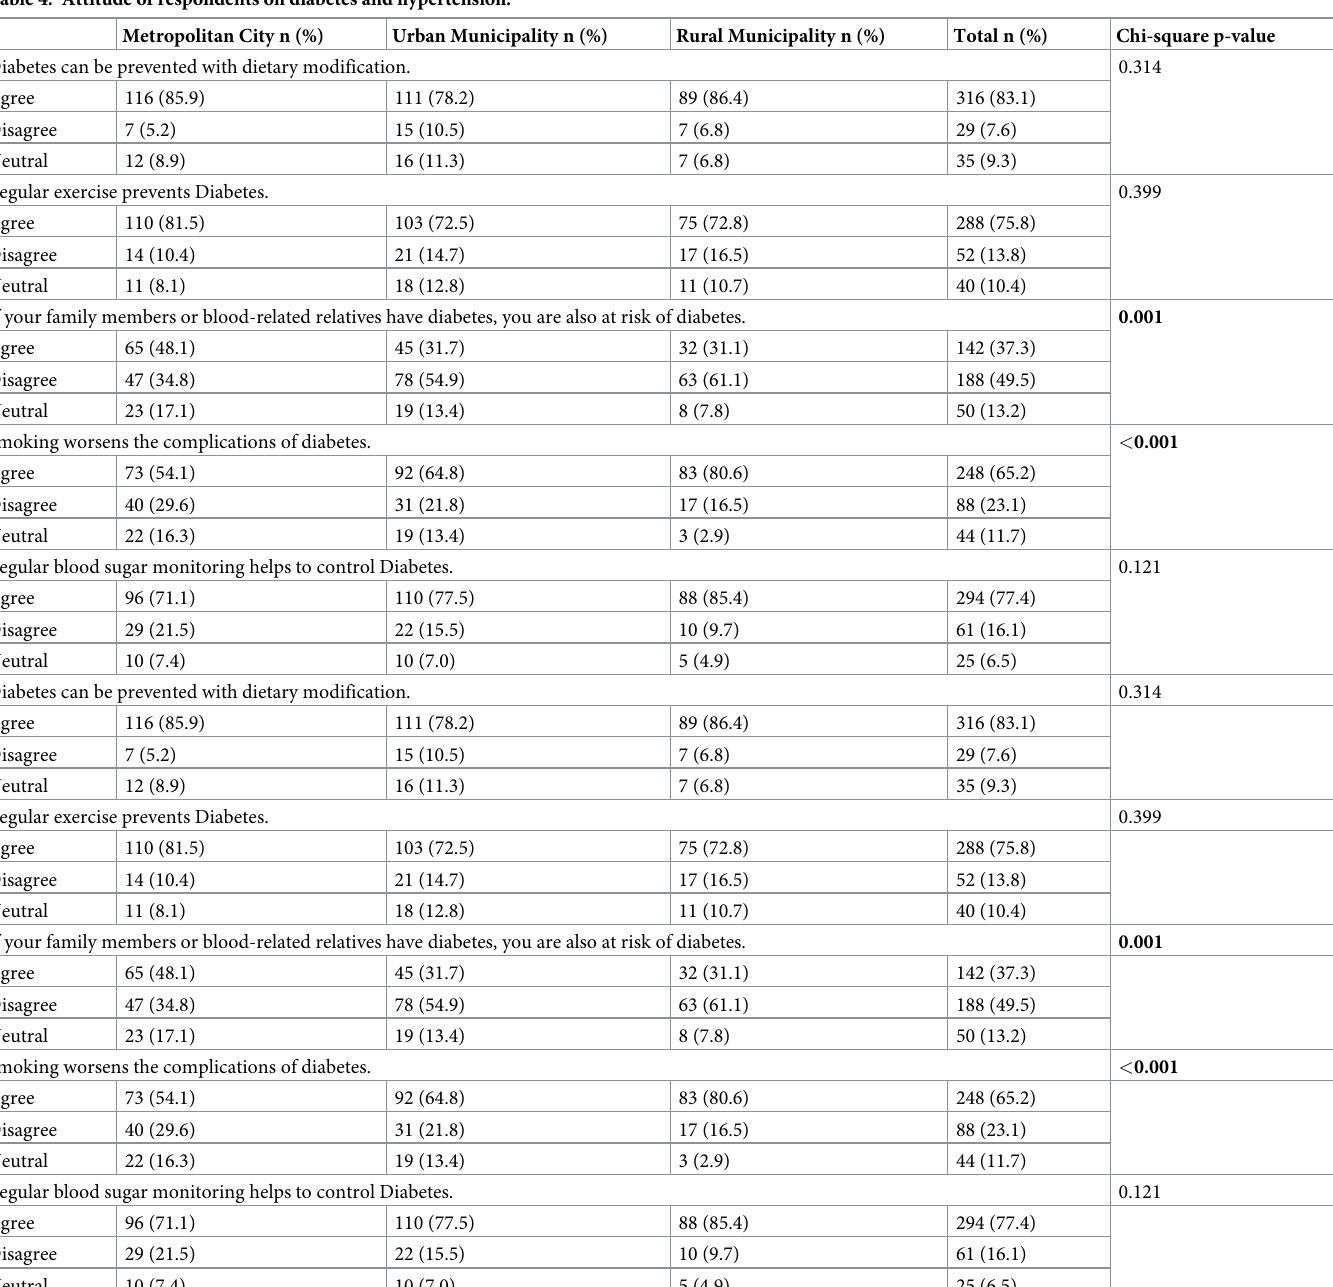
Table 4. Attitude of respondents on diabetes and